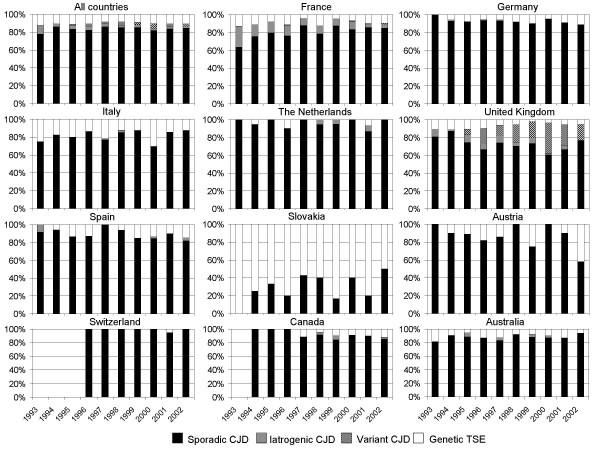
Annual distribution by type of HTSE in eleven countries. Different study intervals for the period, 1993–2002.